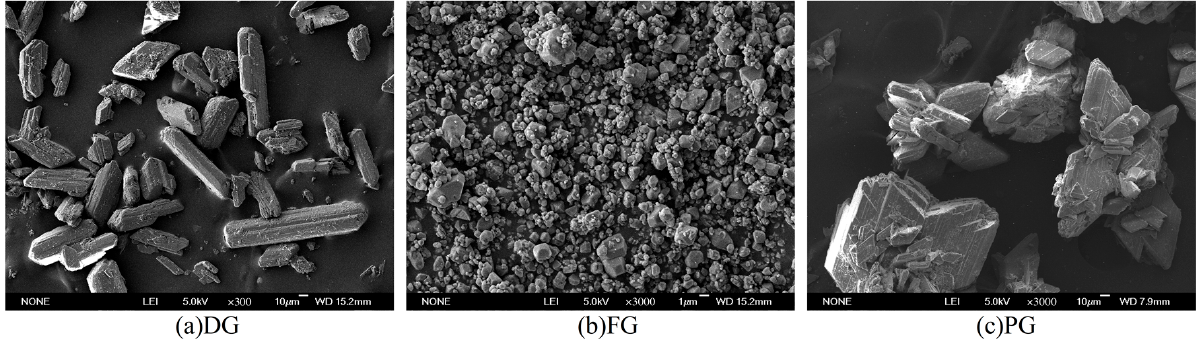
Figure 3. SEM diagram of different gypsum types: ( a ) desulfurization gypsum, ( b ) fluorogypsum ( c ) Phosphogypsum.